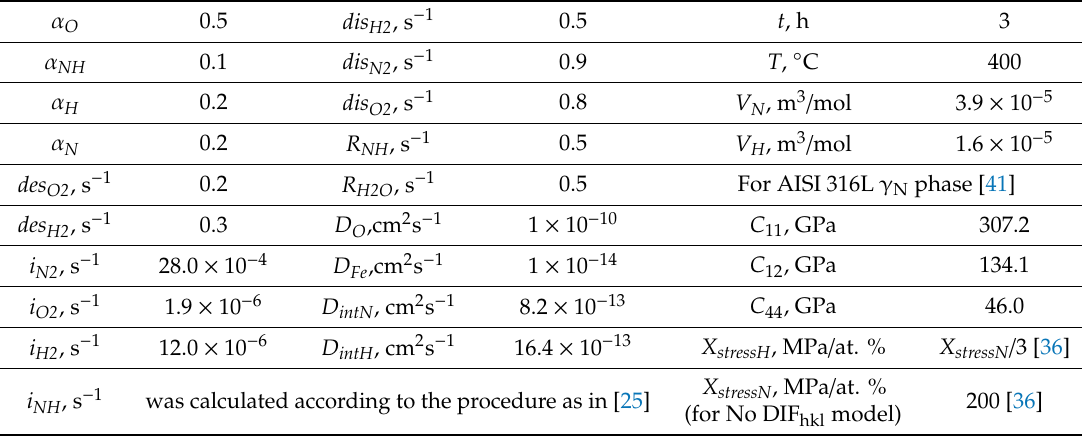
Table 1. Simulation